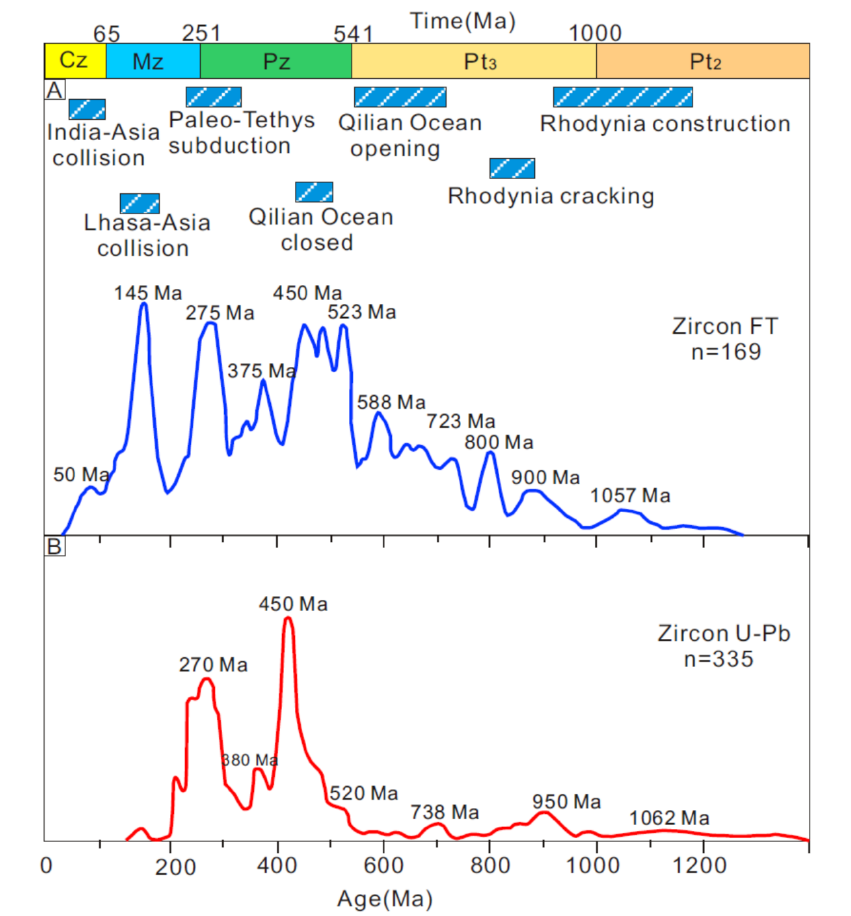
Figure 8. ( A ) Frequency distribution of detrital zircon fission track ages in the upper reaches of the Hei River. ( B ) U-Pb age frequency distribution of Middle Proterozoic and Mesozoic detrital zircons in the Hei River basin. Data source: